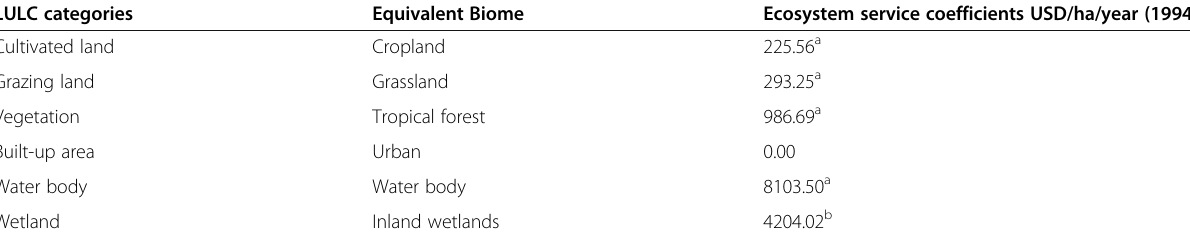
Table 3 The six land use/land cover (LULC) categories, their biome equivalents and valuation coefficients used for ecosystem service values estimation in